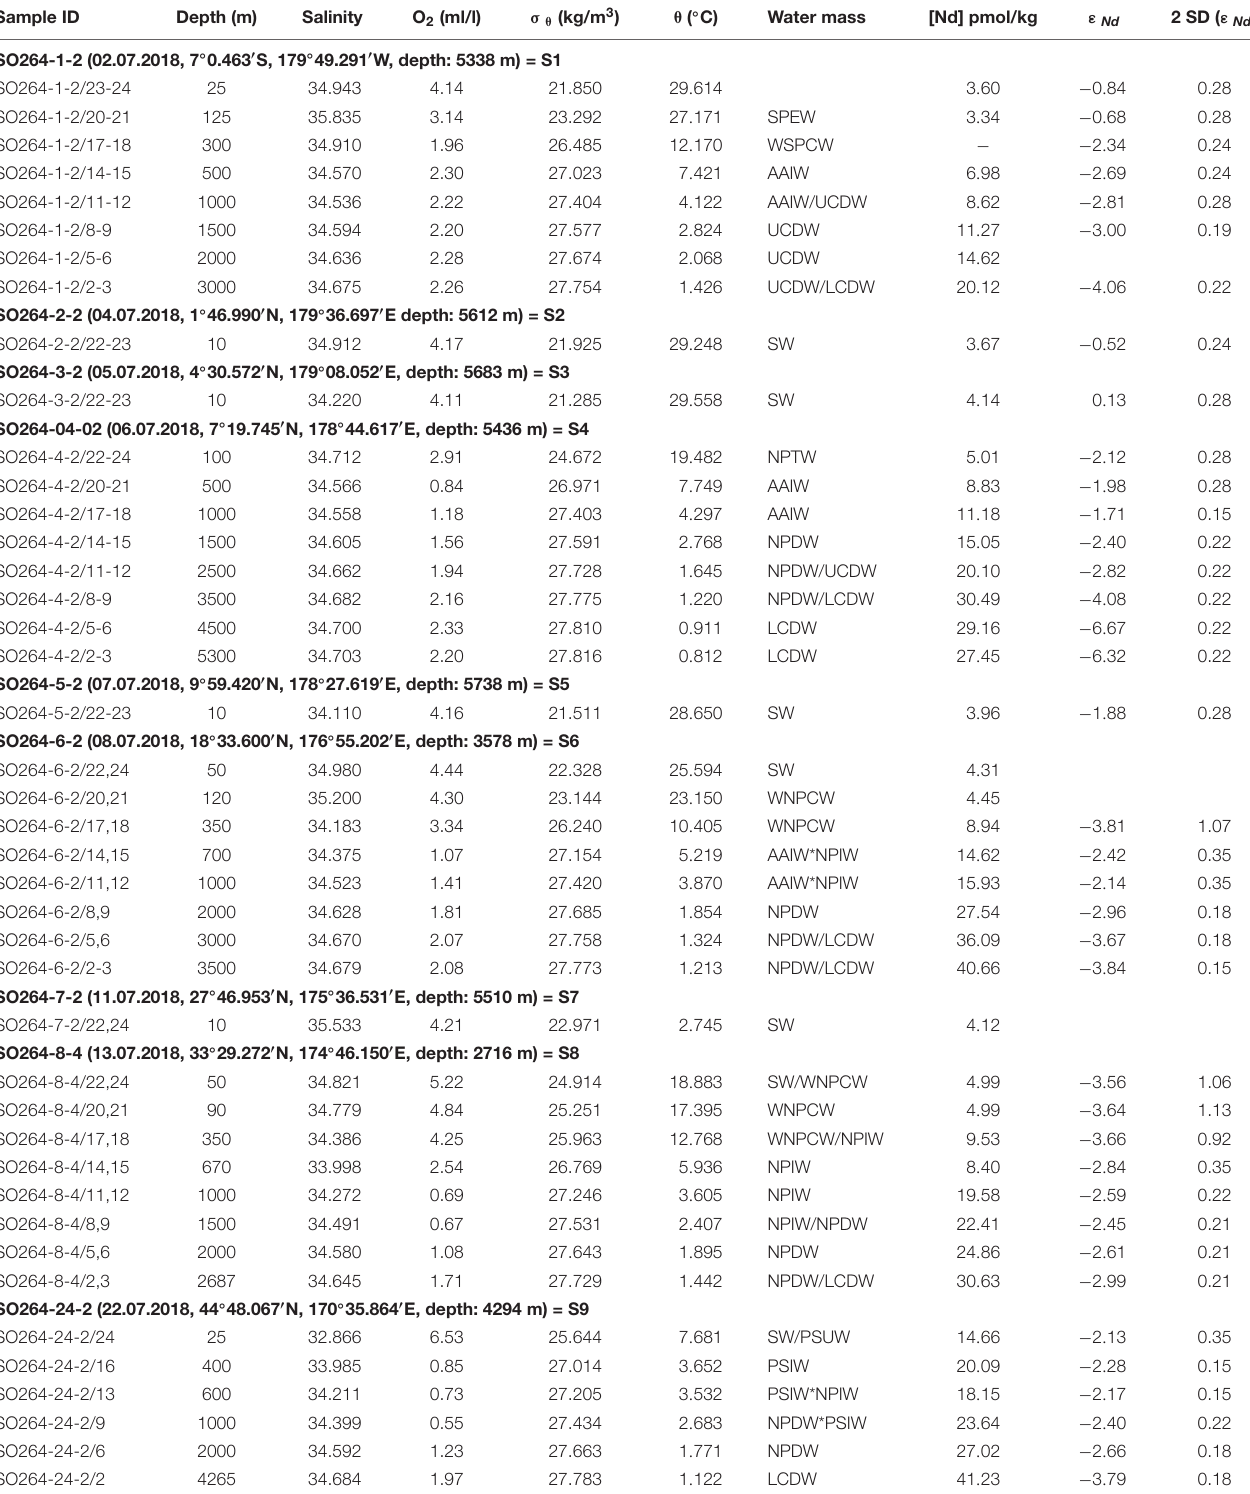
TABLE 2 | Results of seawater Nd isotope composition and concentration from this study along with hydrographic parameters. Sample ID Depth (m) Salinity O 2 (ml/l) σ θ (kg/m 3 ) θ ( ◦ C) Water mass [Nd] pmol/kg ε Nd 2 SD ( ε Nd